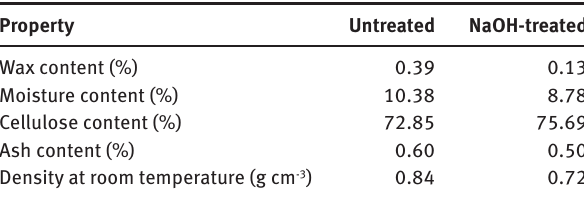
Table 3 Chemical properties of untreated and NaOH-treated